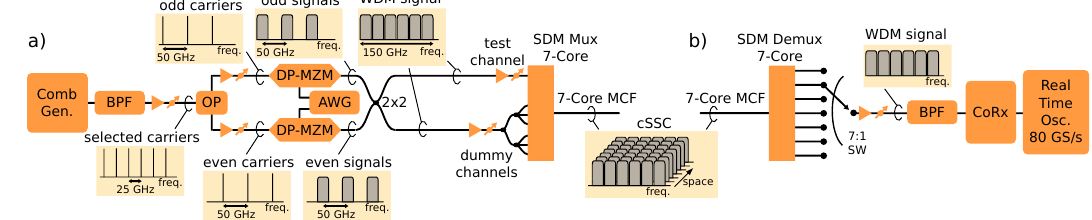
Figure 3. 10 Tb/s circuit spatial super channels (cSSC) ( a ) transmitter and ( b )